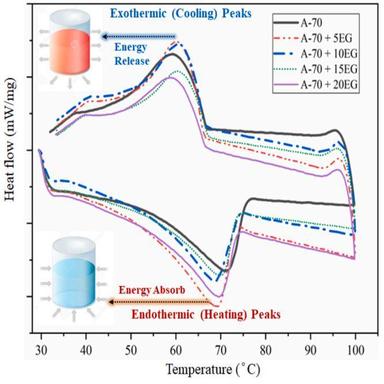
DSC thermograms of A70 PCM and SS-PCM composites.